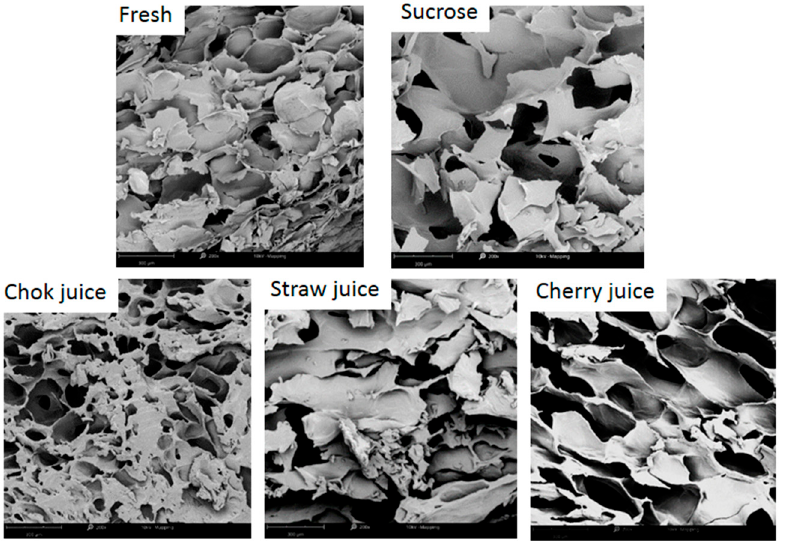
Figure 4. Microstructure (200× magnification) of fresh strawberries osmotically dehydrated for 3 h in solutions of sucrose, chokeberry (chok juice), strawberry (straw juice), and cherry juice concentrates. According to Gamboa-Santos [43], osmotic dehydration by immersion in a sucrose solution of 60° Bx at 40 °C for 4 h causes changes in texture due to the effect of changes in the water content on the pectin and cellulosic components of fruit tissues. The thin cell walls of strawberry tissue may promote damage to the cell texture and the intercellular space. Osmodehydrated samples may have detached cell walls and a damaged mid-lamella as a result of cell plasmolysis and shrinkage [45]. Changes in the shape and volume of cells and intercellular spaces are visible. This is due to the deformation and folding of the surface. It was found that the type of osmotic agent caused changes in the structure of dehydrated strawberries, which became looser in relation to fruits not subjected to dehydration. There was an increase in the volume of internal spaces when the tissue of non-dehydrated strawberries was more compact. In addition, as a result of the saturation of strawberries with sugars and other components of osmotic agents, cell walls thickened. The most damaged structure is characterized by strawberries dehydrated in a cherry juice concentrate, which may be attributed to the greatest effect of removing water from strawberries (WL and WL/SG), as well as the chemical composition of the juice and low pH (approx. 3.2–3.3) of cherry juice (Table 1) [42,46,47]. Prinzivalli et al. [48] showed the effect of extending the osmotic dehydration time of strawberries in a sucrose solution on greater changes in texture. They found that after just 1 h of the process, there was a gradual separation and disintegration of the tissue, loss of the shape of the cell walls, and turgor.